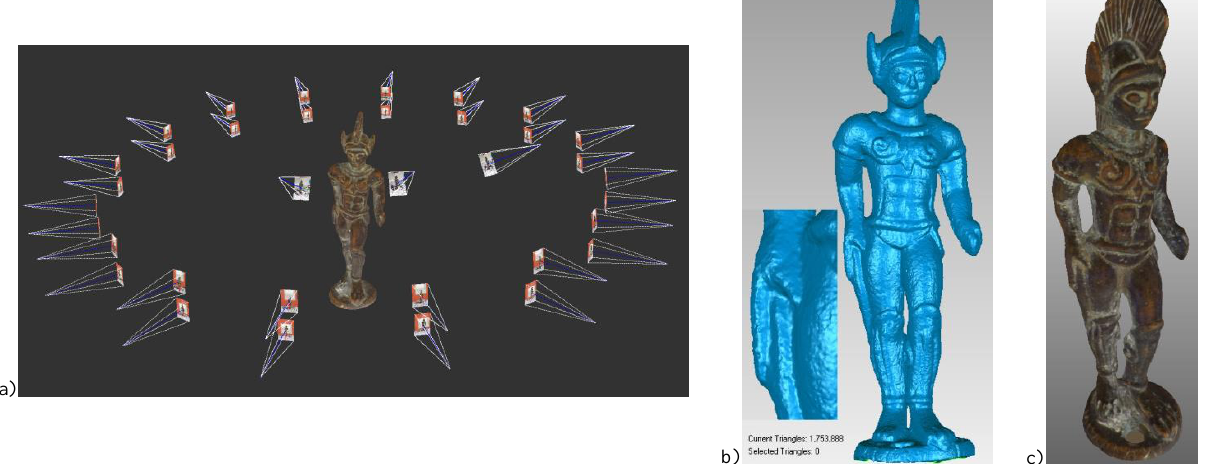
Figure 5: Derived camera network for the bronze warrior (a). Mesh model after the triangulation of the dense point cloud (b) and textured model (c).